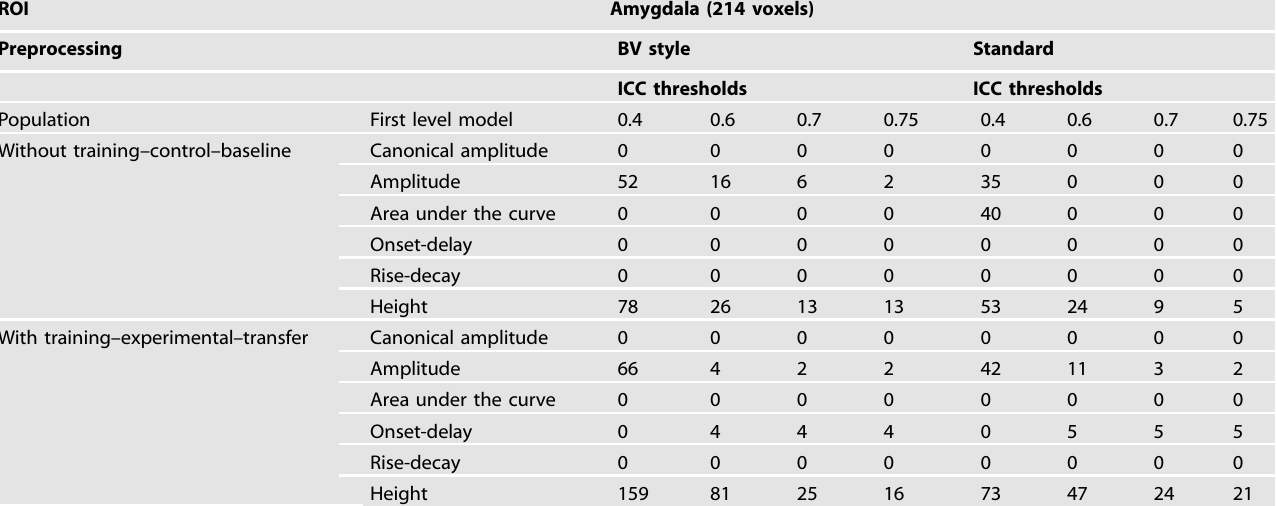
Table 3. Table of number of voxels reaching different reliability thresholds for each sample, preprocessing, and fi rst-level parameter with cluster correction